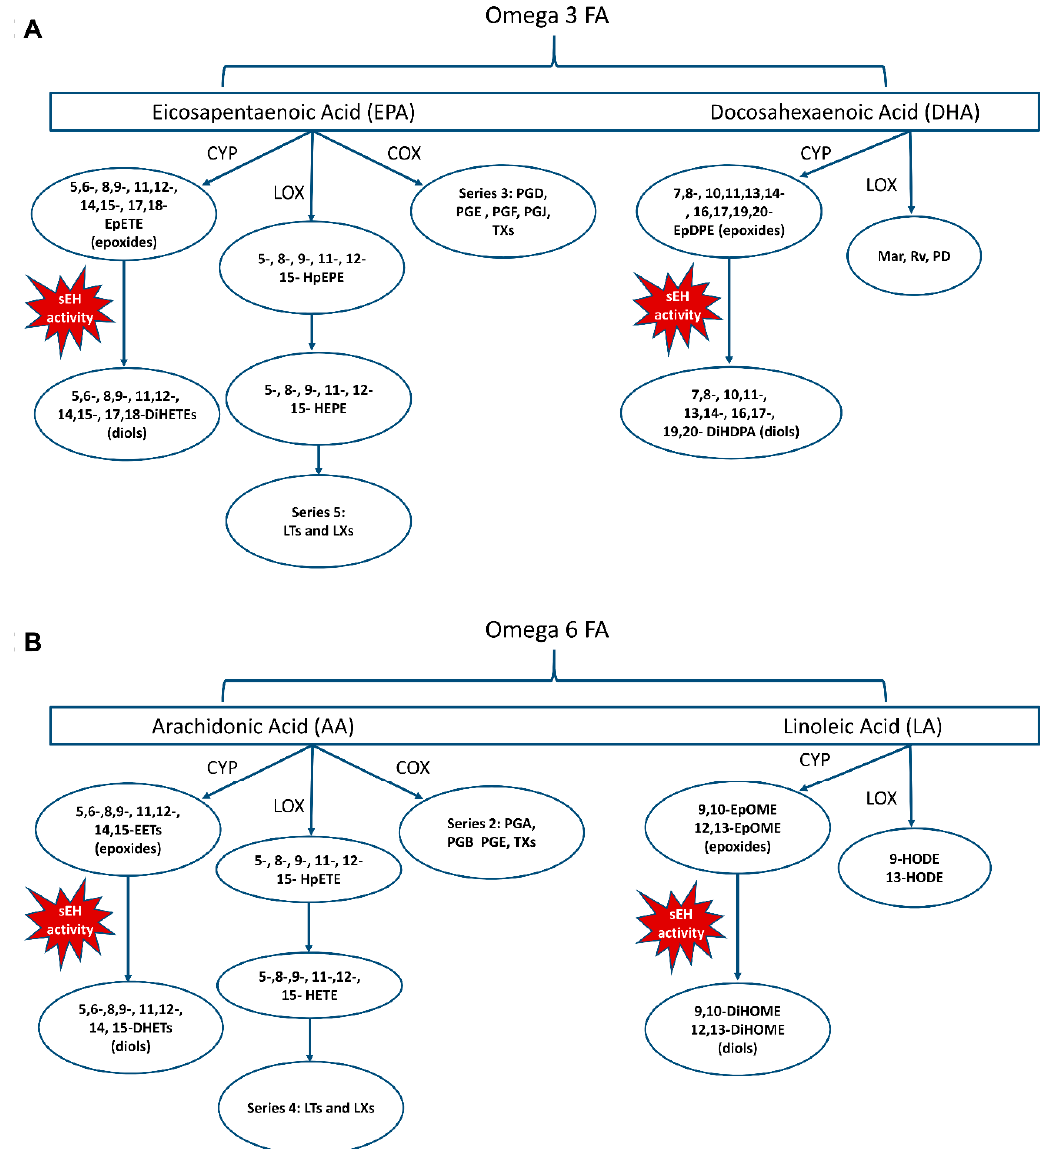
Figure 3. ( A ) Enzymatic oxidation of n-3 PUFAs forming oxylipins. n-3: EPA, eicosapentaenoic acid; DHA, docosahexaenoic acid. ( B ) Enzymatic oxidation of n-6 PUFAs forming oxylipins. N-6: AA, arachidonic acid; LA, linoleic acid. COX, cyclooxygenase; CYP, cytochrome P450; sEH, soluble epoxide hydrolase, which converts epoxides to diols. See Supplementary Table S1, Select Oxylipin Nomenclature, for the full names of oxylipin